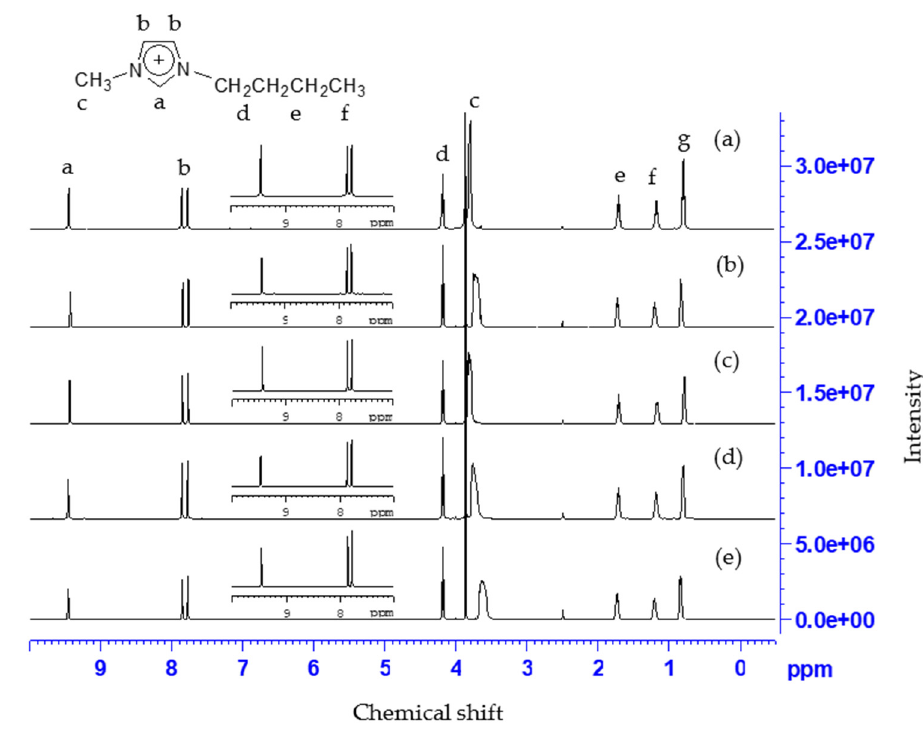
Figure 4. The 1 H NMR spectra of ( a ) [C 4 mim]Cl, ( b ) Cr-contaminated simulated sorbent in soil remediation–extracted [C 4 mim]Cl, ( c ) vermiculite-extracted [C 4 mim]Cl, ( d ) humic acid–extracted [C 4 mim]Cl, and (e) Cr(VI)–extracted [C 4 mim]Cl.